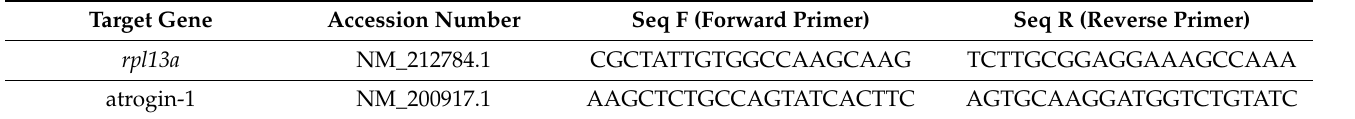
Table 1. Sequences of gene-specific primers used in the real-time quantitative PCR